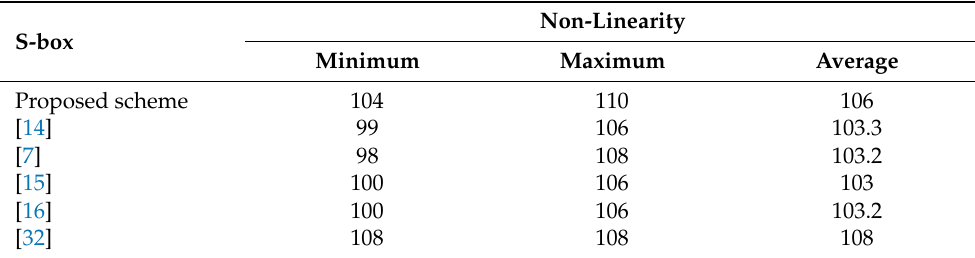
Table 3. Comparison of the